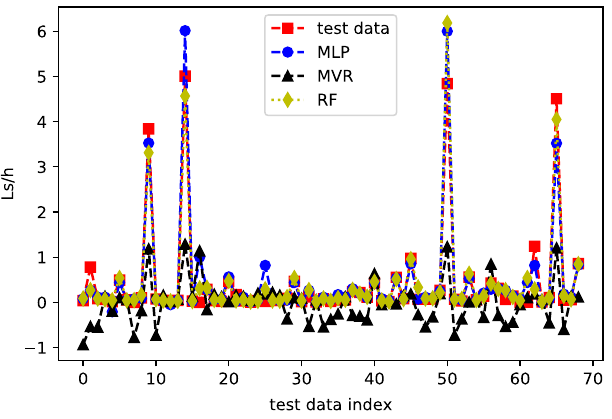
Figure 5. Comparison plot for test, MLP, MVR and RF data. Lines are guide to the